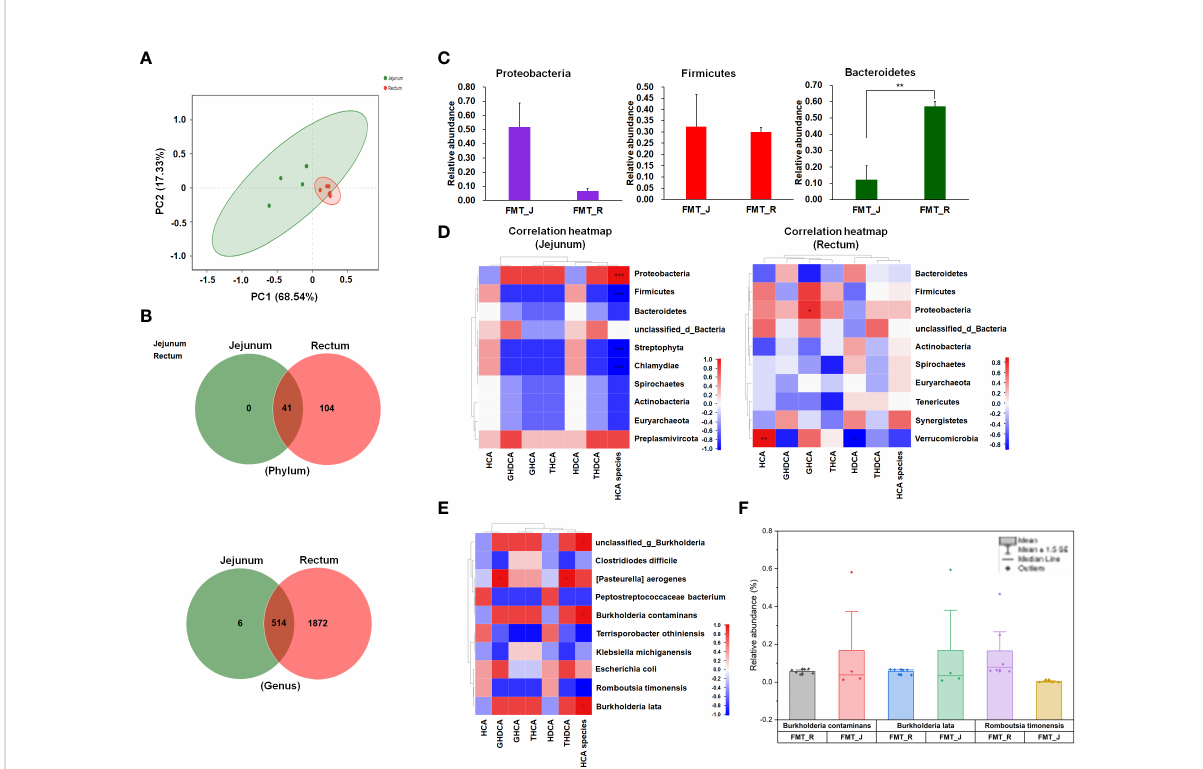
FIGURE 5 Comparison of jejunal and rectal microbiota in FMT piglets. (A) Principal coordinate analysis (PCoA). (B) Venn diagram analysis of bacterial phyla and genera between jejunal and rectal microbiota of FMT piglets. (C) Relative abundance of three main bacterial phyla between jejunal and rectal microbiota of FMT piglets. FMT_J represents the jejunal samples of FMT piglets; FMT_R represents the rectal samples of FMT piglets. An independent t test was used to identify differences between groups. * P < 0.05, ** P < 0.01. (D) Spearman ’ s rank correlation heatmap between the concentrations of HCA species and the bacterial phyla in intestinal contents (jejunum or rectum) is shown. (E) Correlation heatmap between the concentrations of HCA species and the bacterial species in intestinal contents (jejunum or rectum). Correlation coef fi cient R values are shown in different colors. (F) Box chart (mean with SE) of the relative abundances of B. contaminans, B. lata, and R. timonensis in the jejunal and rectal samples of FMT piglets. Correlation coef fi cient R values are shown in different colors. Asterisk (*) in the table cells represent signi fi cant correlations at the 0.05 level (two-tailed). ** in the table cells represent signi fi cant correlations at the 0.01 level (two-tailed); *** represent signi fi cant correlations at the 0.001 level